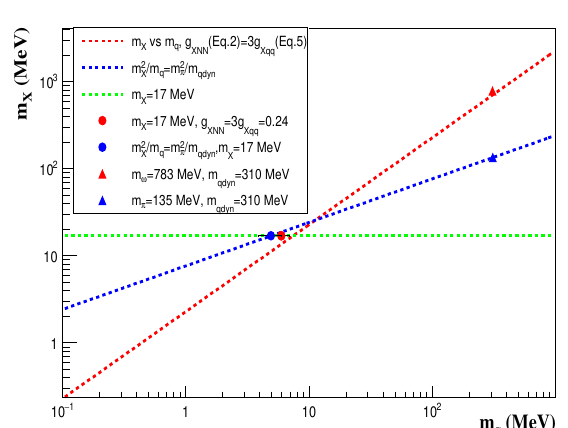
Figure 1: (Color online). Trends of mesonic versus quark masses. First trend combines formulas (2) and (5) as ex- plained in the text. Second trend represents formula (4).